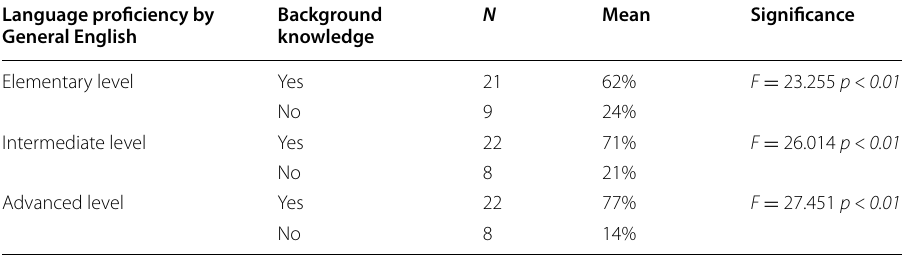
Table 6 Reading test (text 1) according to language proficiency (General English) and background knowledge: comparison of means